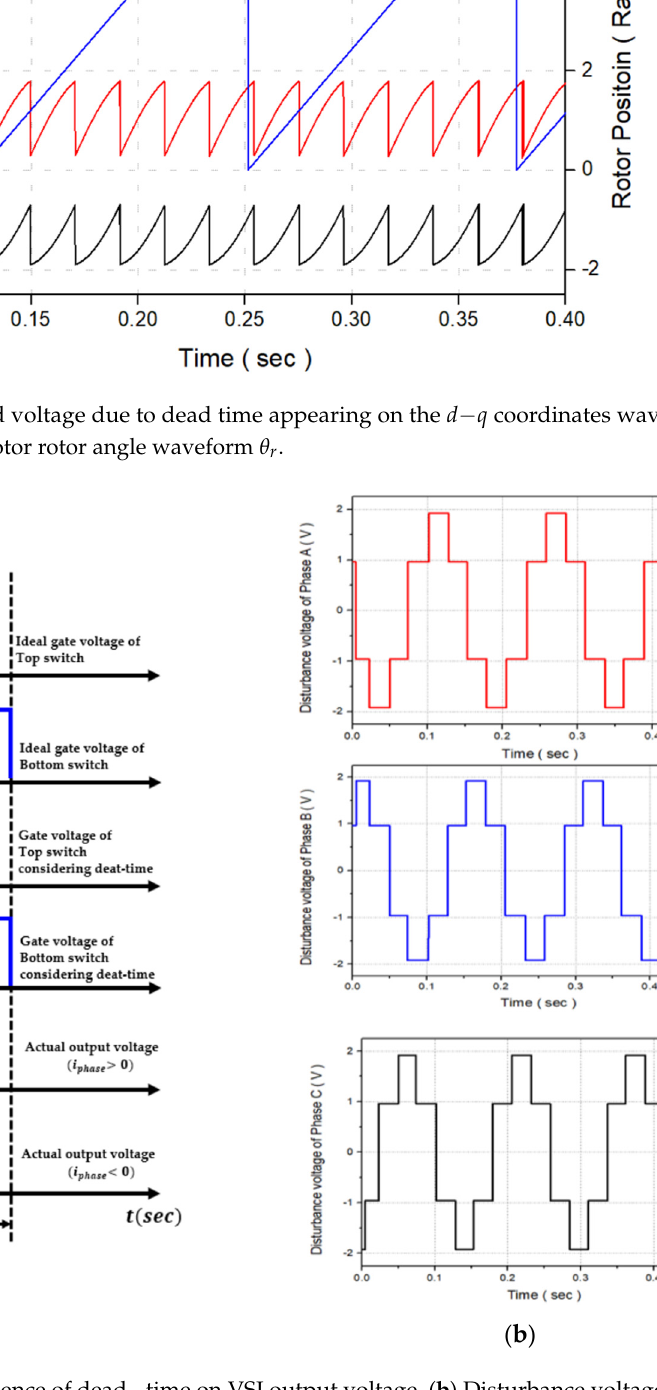
Figure 10. ( a ) Influence of dead − time on VSI output voltage, ( b ) Disturbance voltage generated in each phase of the motor by the dead time .